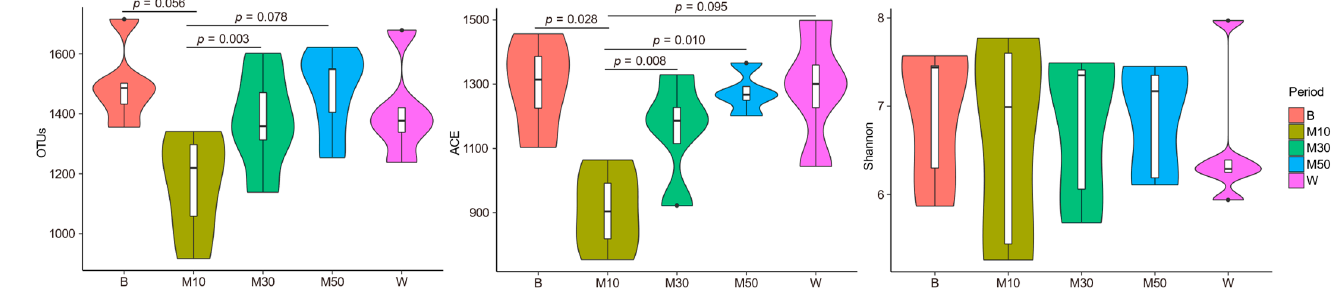
Figure 1. Dynamics of the observed OTUs and α diversity of the ruminal bacterial community following monensin treatment in goats. Note: B, baseline period; M10, M30, and M50, on d 10, 30, and 50 of the treatment period; W, washout period; p , p -value.